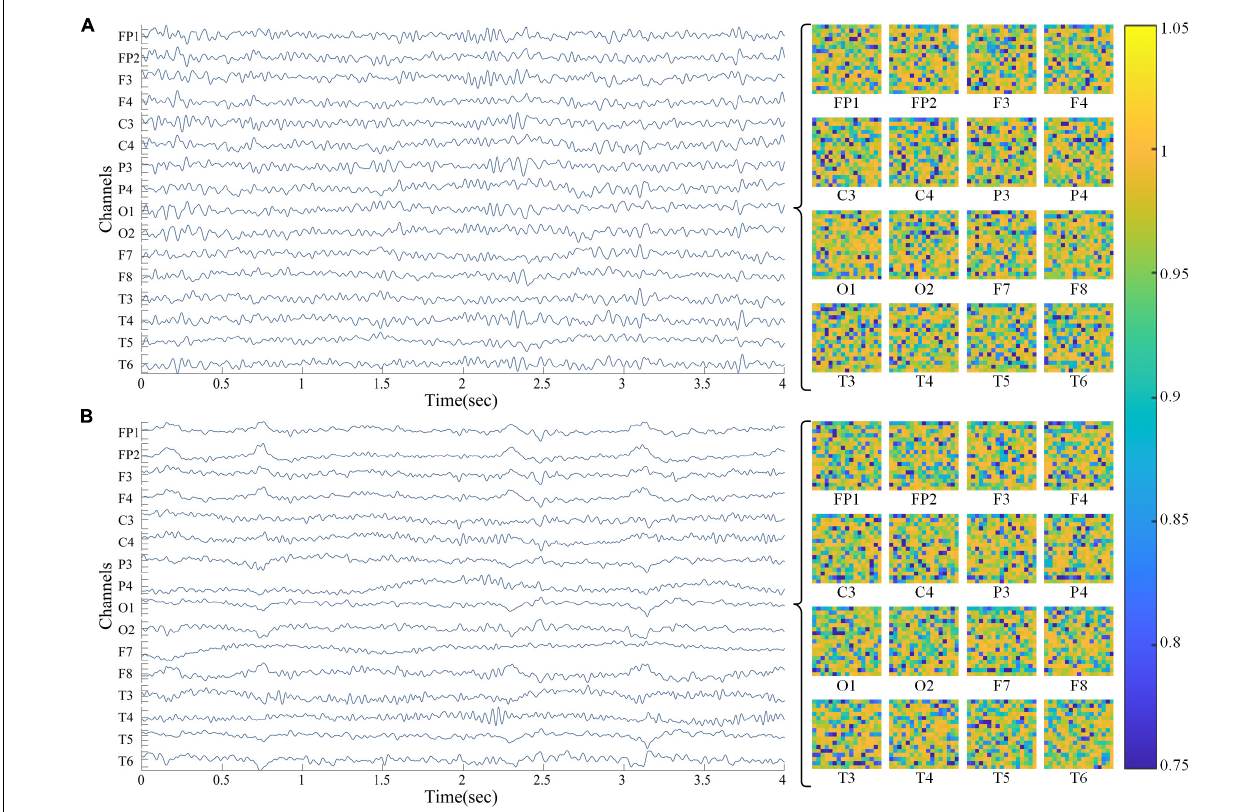
FIGURE 1 | EEG and spectral entropy heat maps from subjects. (A) HC group; (B) aMCI group. The area on the left shows a 16-channel EEG, and the area on the right shows a 2-D spectral entropy image of the corresponding channel. In the spectrum entropy heat map, the abscissa is time and the ordinate is frequency bin.